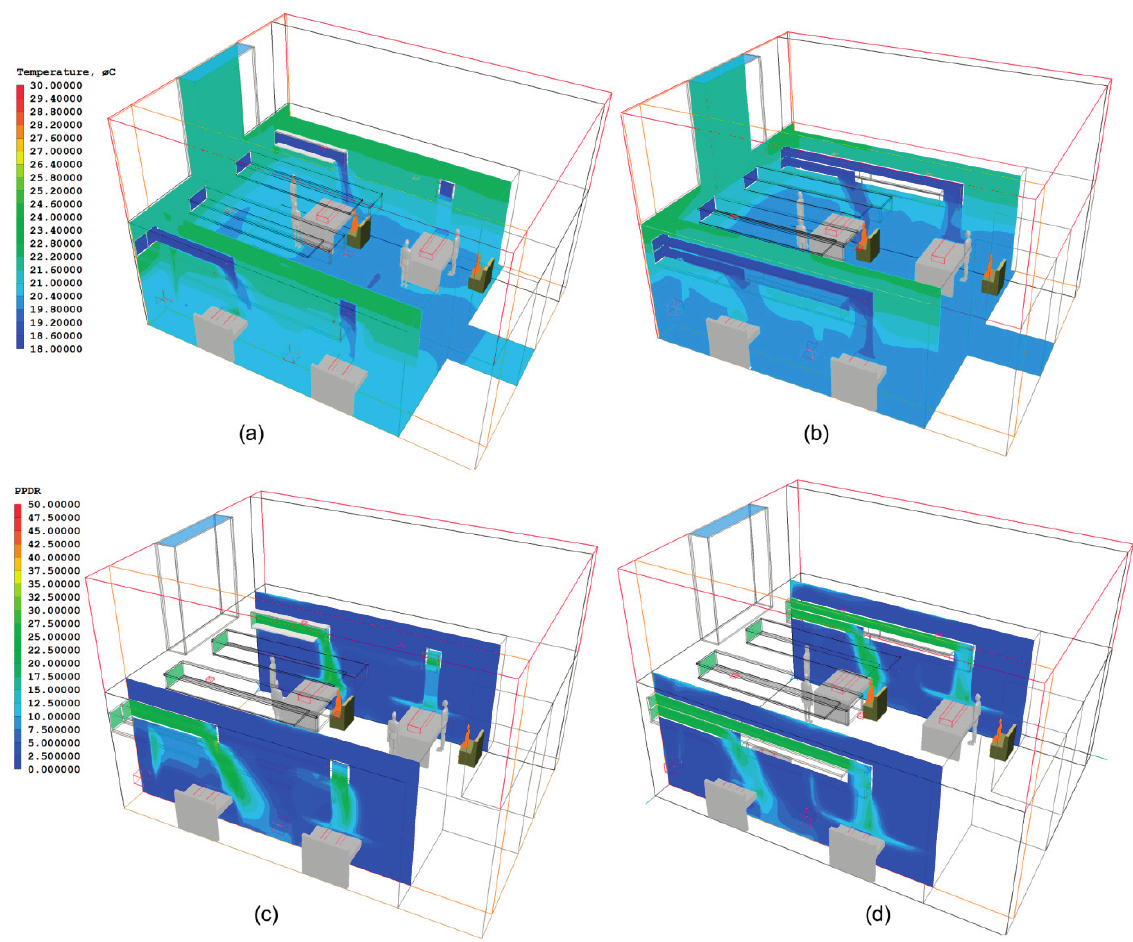
Figure 5. Temperature contours for: ( a ) NPV Case 1; and ( b ) NPV Case 2 showing horizontal throw of fresh air from shorter ducts; with draught potential for ( c ) NPV Case 1; and ( d ) NPV Case